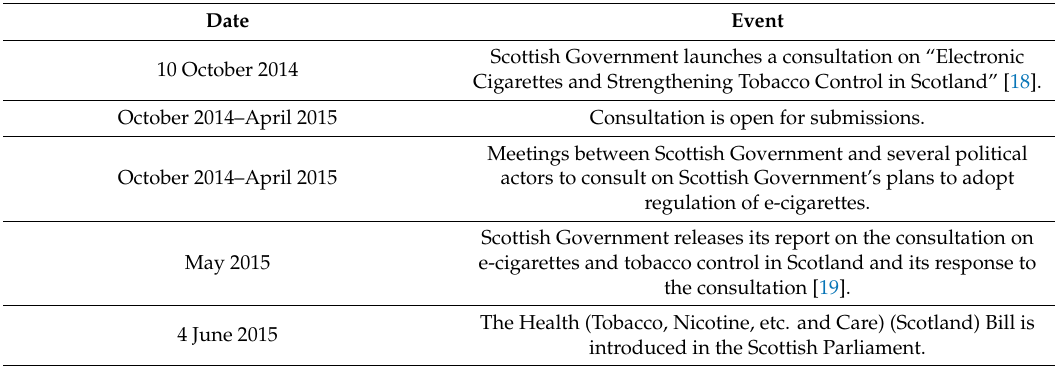
Table 1. Chronology of the development of the Health (Tobacco, Nicotine etc. and Care) (Scotland) Act of